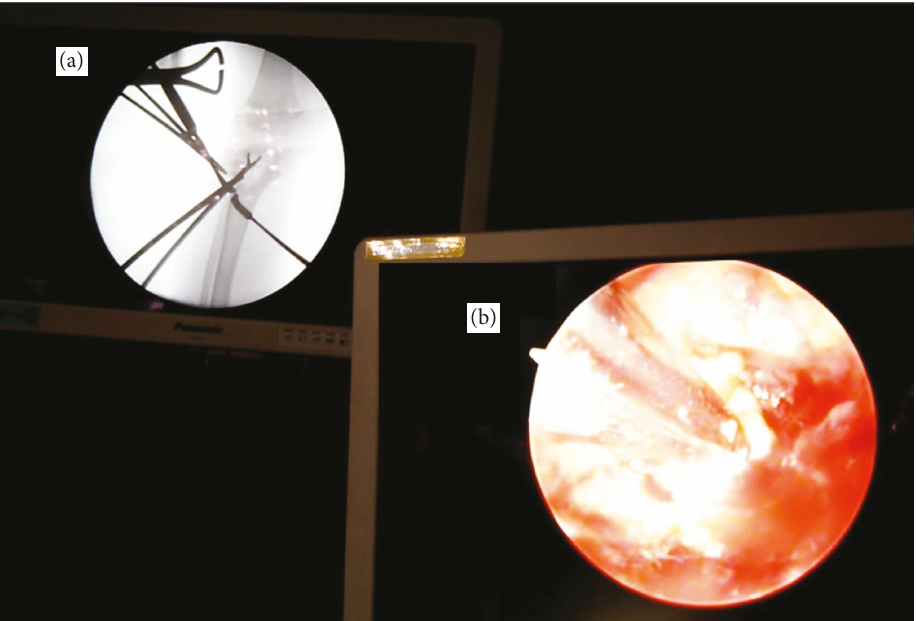
Figure 3: Surgical drainage and curettage of the lesion were performed with an endoscope under C-arm fl uoroscopy using double monitors. (a) Fluoroscopic monitor. (b) Endoscopic monitor.